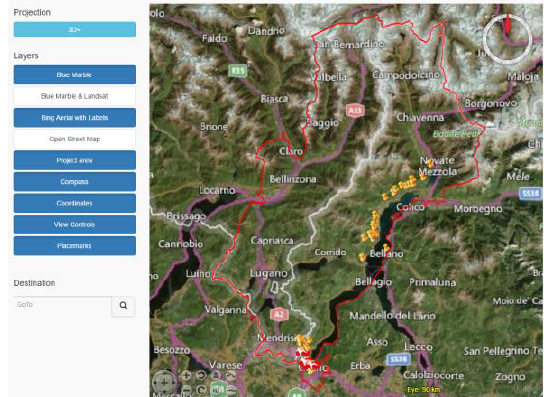
Figure 7. ODK POIs and CouchDB POIs on virtual globe, based on NASA Web World Wind API The data of each POI is displayed inside a popup upon clicking the marker as shown in Figure 8.